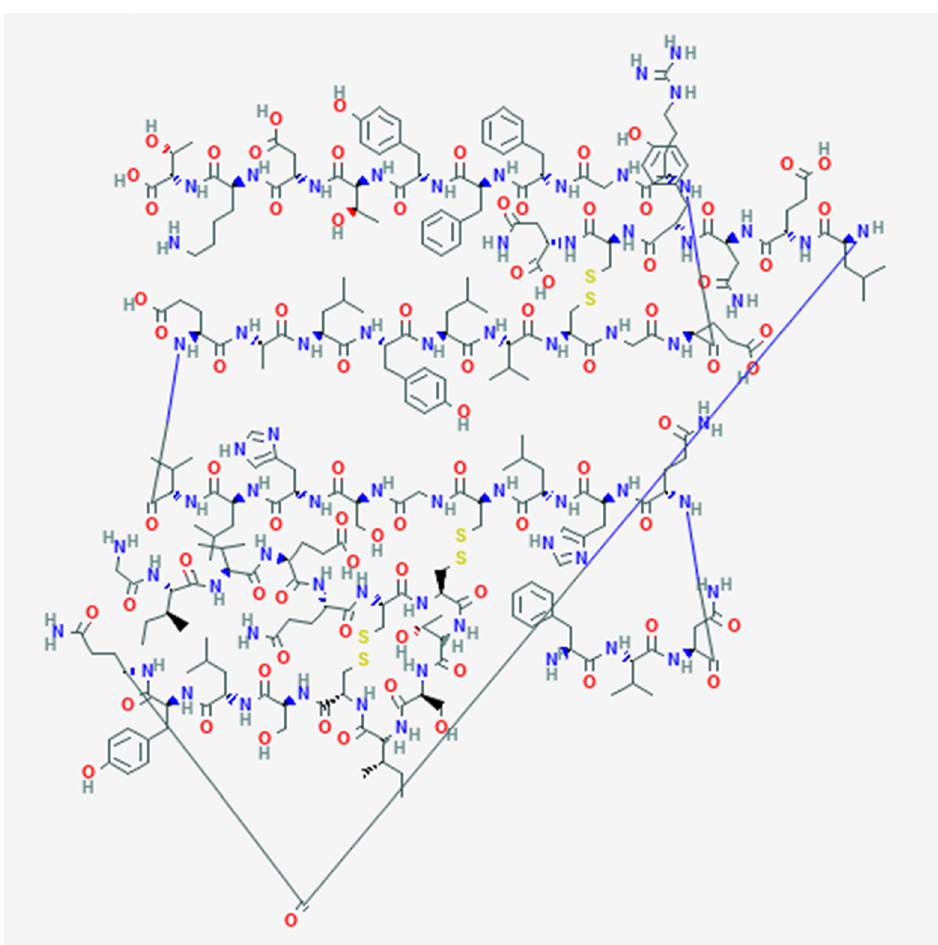
Figure 2: The two - dimensional chemical structure of insulin [ 51 ]